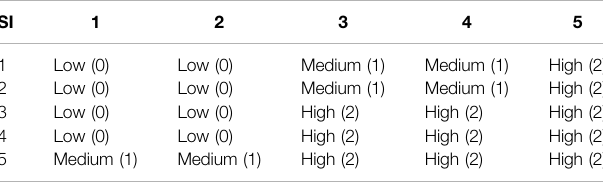
The scores are based on impact (I) and substitutability (S). Low (0): implies no further consideration; medium (1) implies further expert input and inclusion depending on context, and high (2) implies this relationship should be considered in the decision